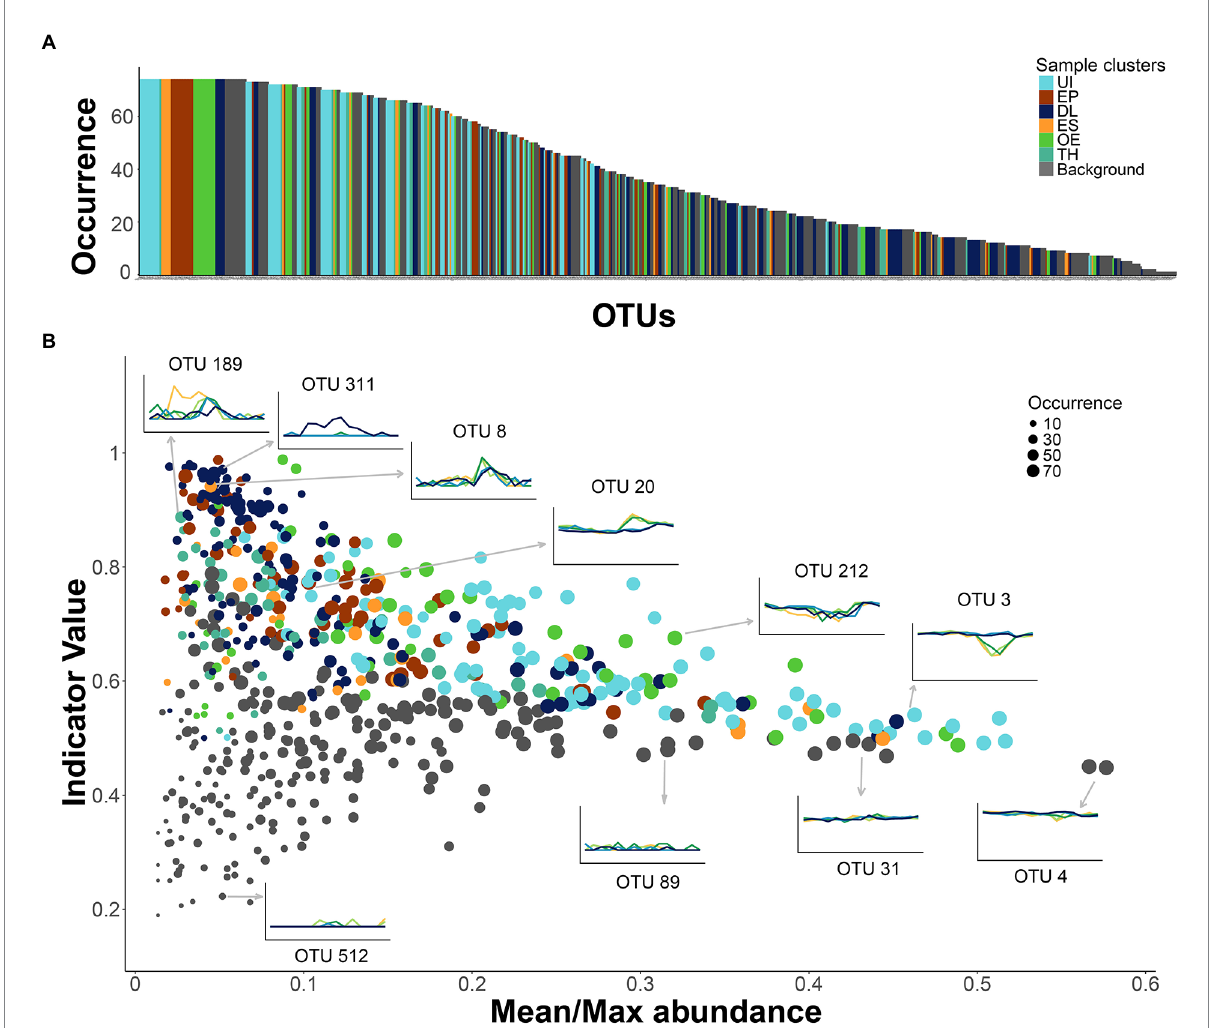
FIGURE 6 Patterns of occurrence and seasonality in the bacterioplankton community. (A) OTUs ranked by occurrence in the samples. Colors specify cluster indicators: UI (under-ice), TH (thaw and hypolimnion), ES (early stratification), EP (epilimnion), OE (overturn and early under-ice), and DL (deep layer). (B) Comparison of the OTU indicator values with the OTU’s mean and maximum abundance ratio in the samples. A larger ratio indicates flatter seasonal OTU profiles, that is, lower occasional blooming. The symbol size is proportional to OTU occurrence. The inserted plots show examples of the OTU abundance’s time series at each sampling depth (line colors as in Figure 2). Arrows indicate the corresponding OTU in the larger